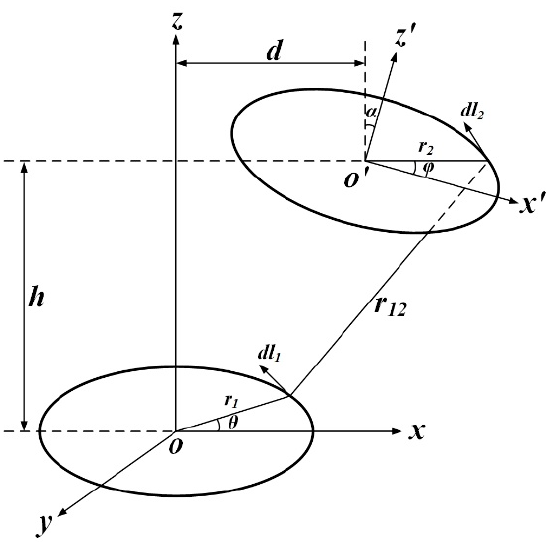
Figure 2. Single-turn transmitter and receiver coils at any spatial location.